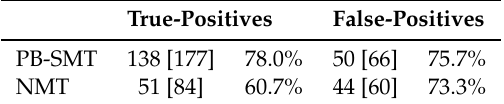
Table 13. True-positives and true-negatives of ILS while using the PB-SMT t-table. Numbers inside square brackets represent the total number of true-positives and false-positives of